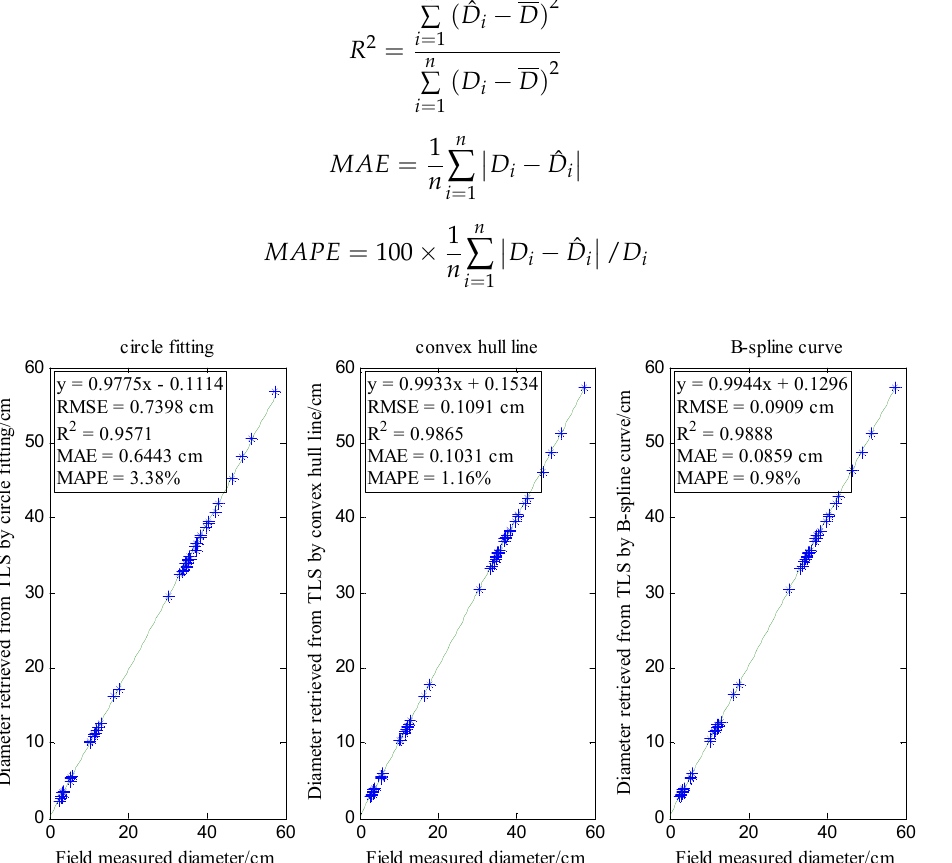
Figure 8. The results of the regressions between the field-measured diameters and the TLS-derived diameters.